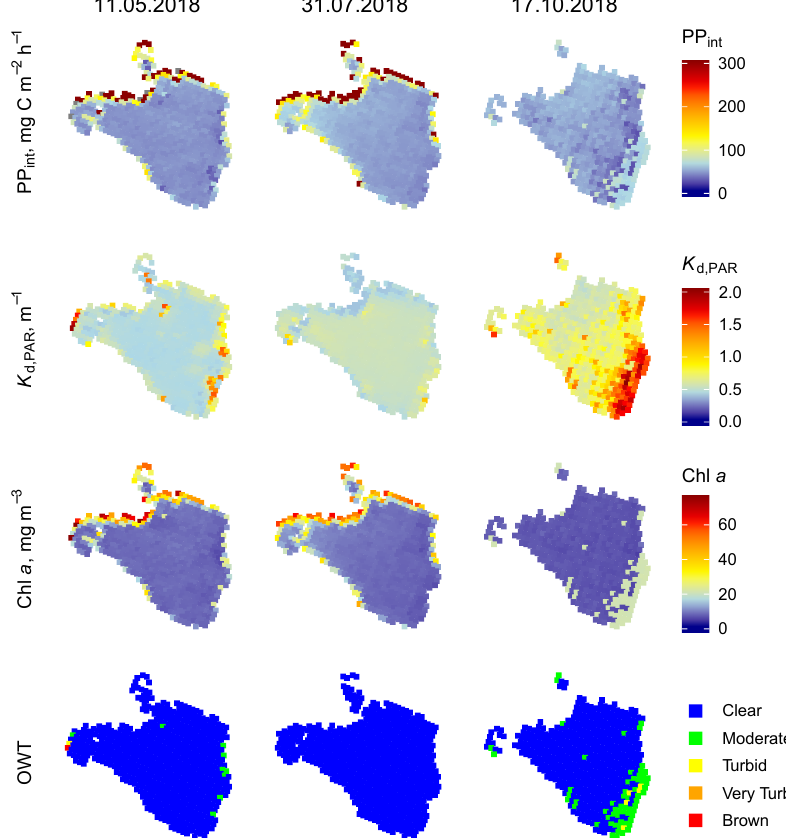
Figure 2. Three examples of the modelled integral primary production (PP int , mg C m − 2 h − 1 ) (first row), attenuation coe ffi cient in the photosynthetically active region ( K d,PAR , m − 1 ) (second row), chlorophyll- a (Chl a , mg m − 3 ) (third row), and optical water type (OWT) (fourth row) of Lake Razna derived from Ocean and Land Color Instrument (OLCI)